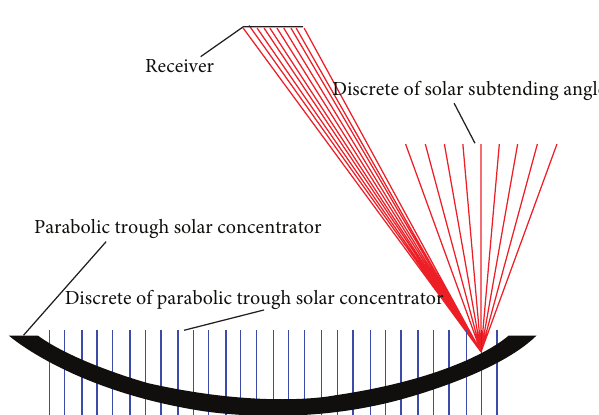
Figure 6: Schematic of the numerical method for energy density distribution.